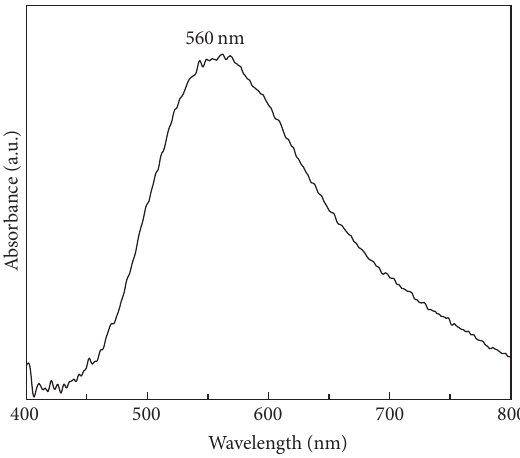
Figure 2: Infrared absorption spectra of copper-amino acids chelate.